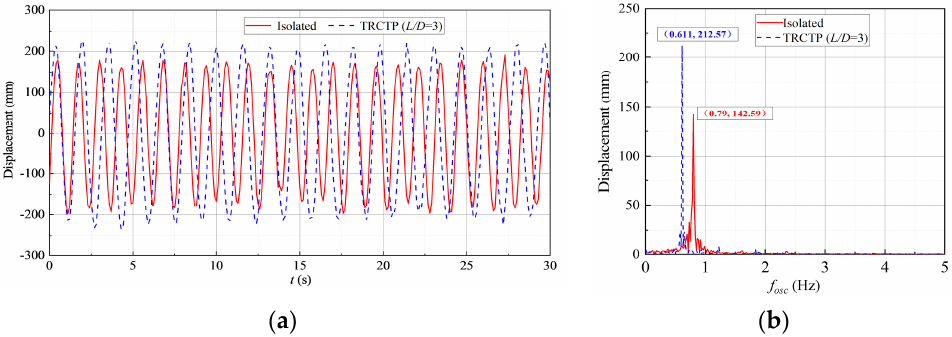
Figure 14. Typical displacement and spectra at U r = 11 ( L / D = 3). ( a ) Comparison of displacement time history; ( b ) Comparison of spectra.